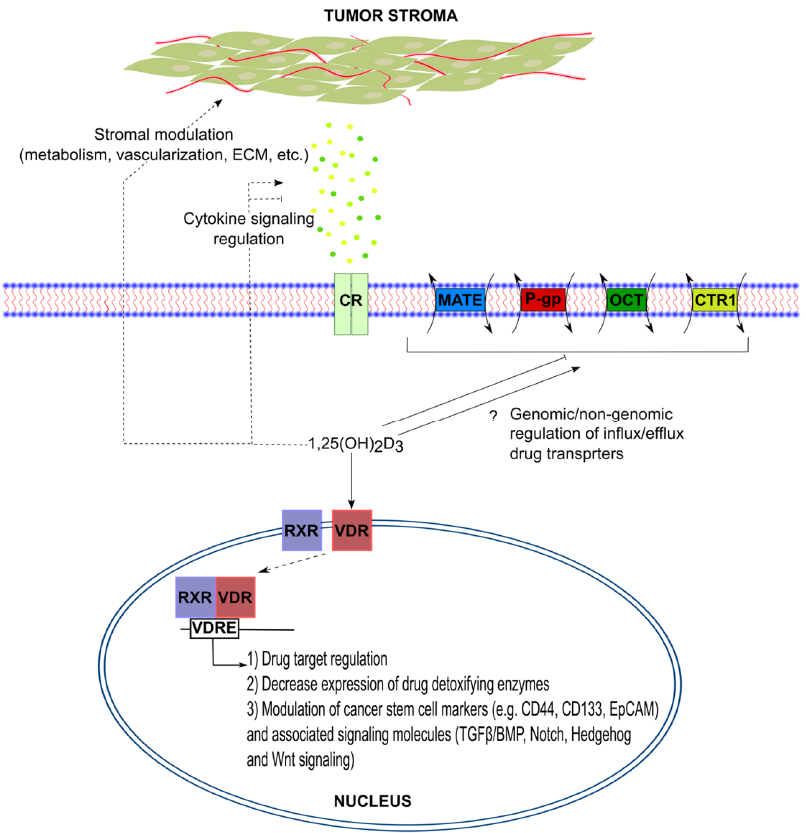
Figure 3. Overcoming chemoresistance with 1,25(OH) 2 D 3 . Through genomic or non ‐ genomic mechanisms, 1,25(OH) 2 D 3 may affect the various players involved in mediating resistance to chemotherapeutics, such as modulating tumor microenvironment, cancer stem cell signaling, as well as drug influx, efflux, and metabolism.